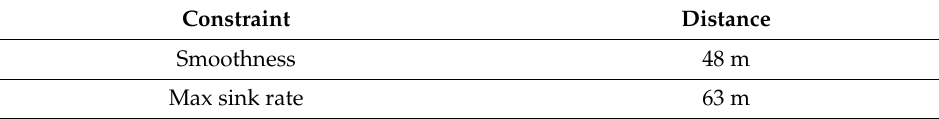
Table 1. Economic parameters. Table 3. Scheduling